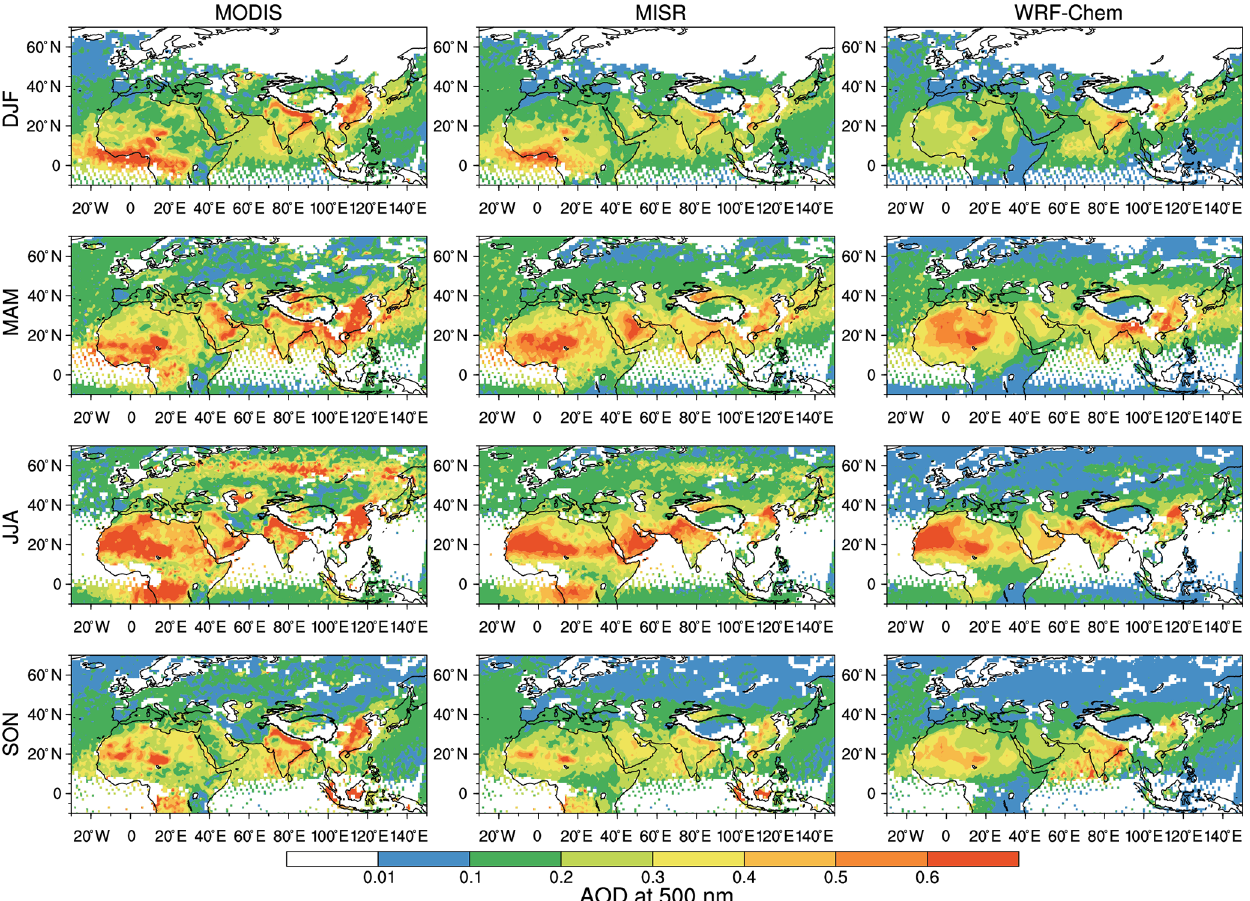
Figure 2. Spatial distributions of seasonal mean AOD at 550nm from the retrievals of MODIS and MISR on board Terra and from the WRF-Chem simulation for the period of 2010–2015. The daily results from MISR, MODIS, and WRF-Chem are only sampled for averaging when all of them have valid values at the same location and